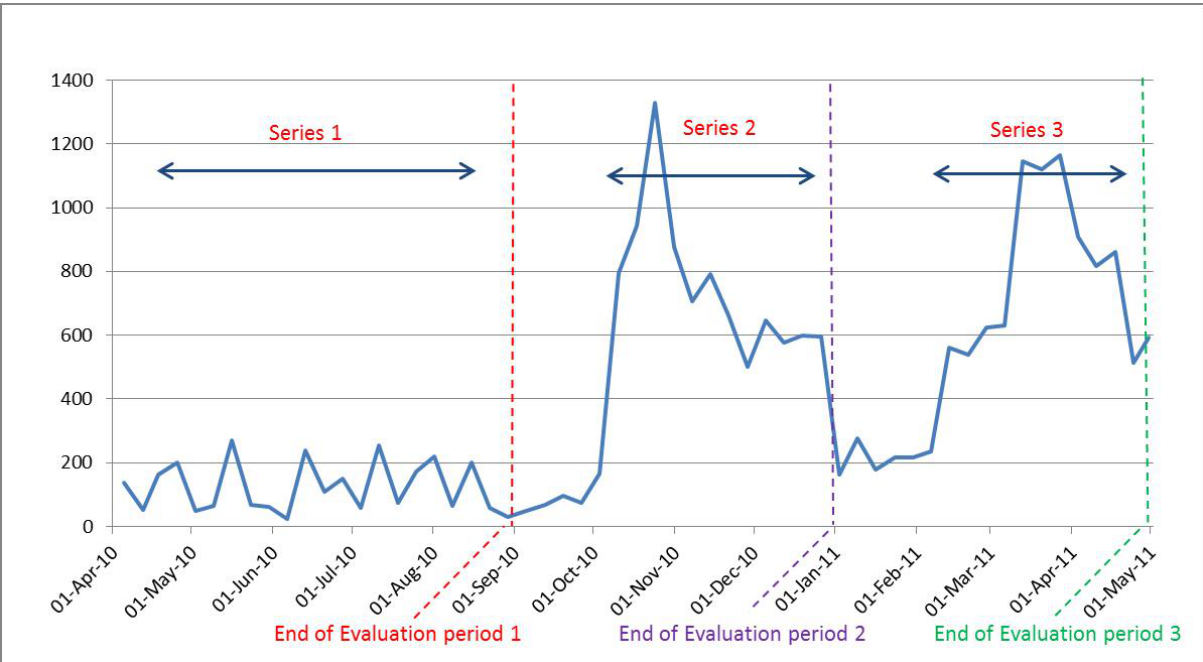
Figure 6. Total number of weekly video views, on QAF Facebook page from Series